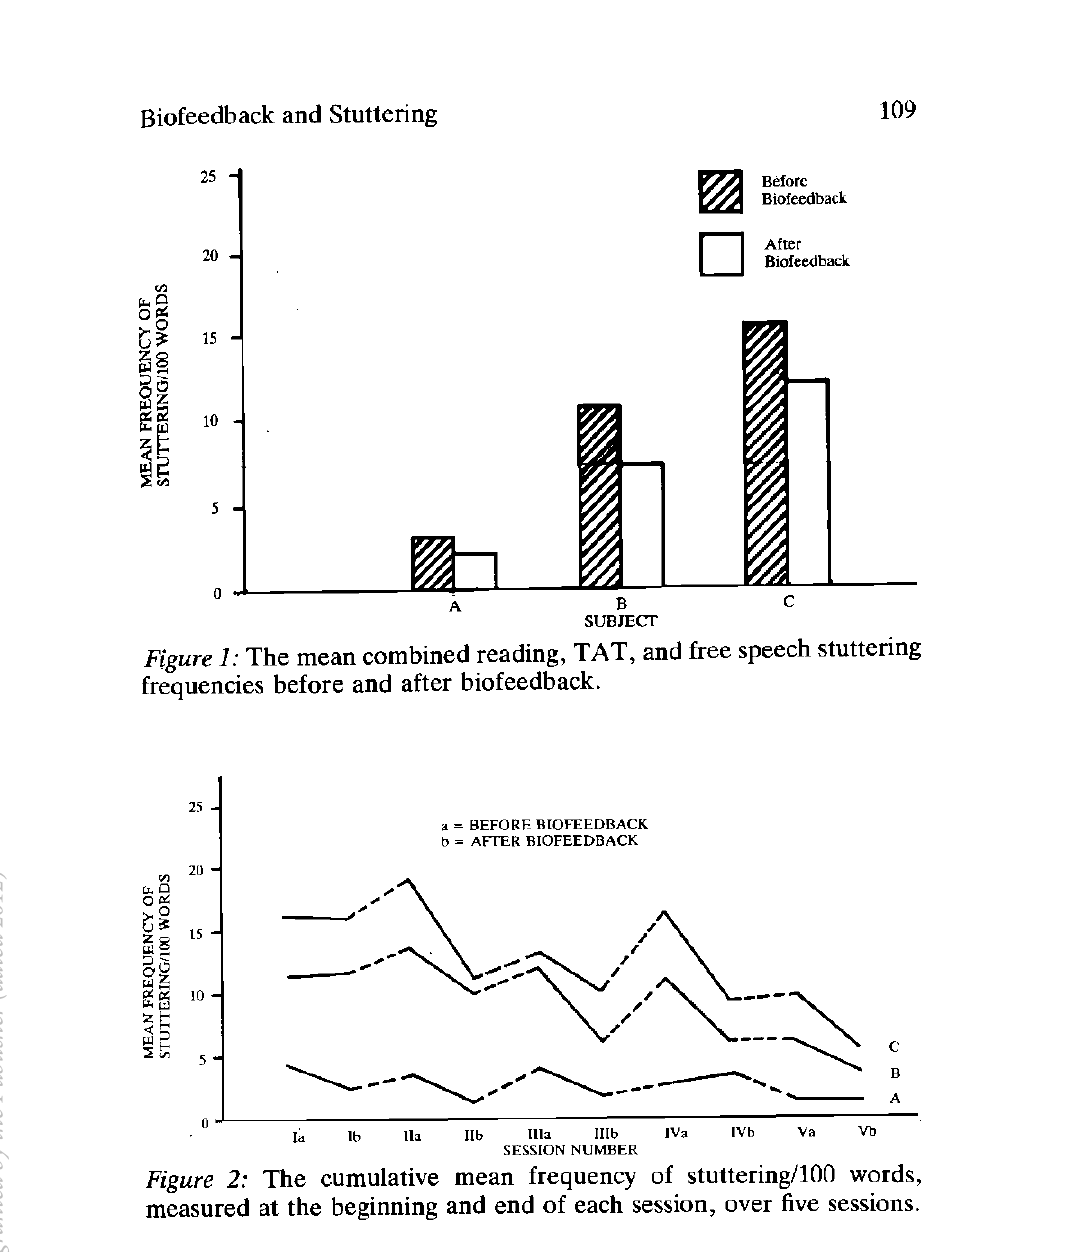
Figure 2: The cumulative mean frequency of stuttering/100 words, measured at the beginning and end of each session, over five